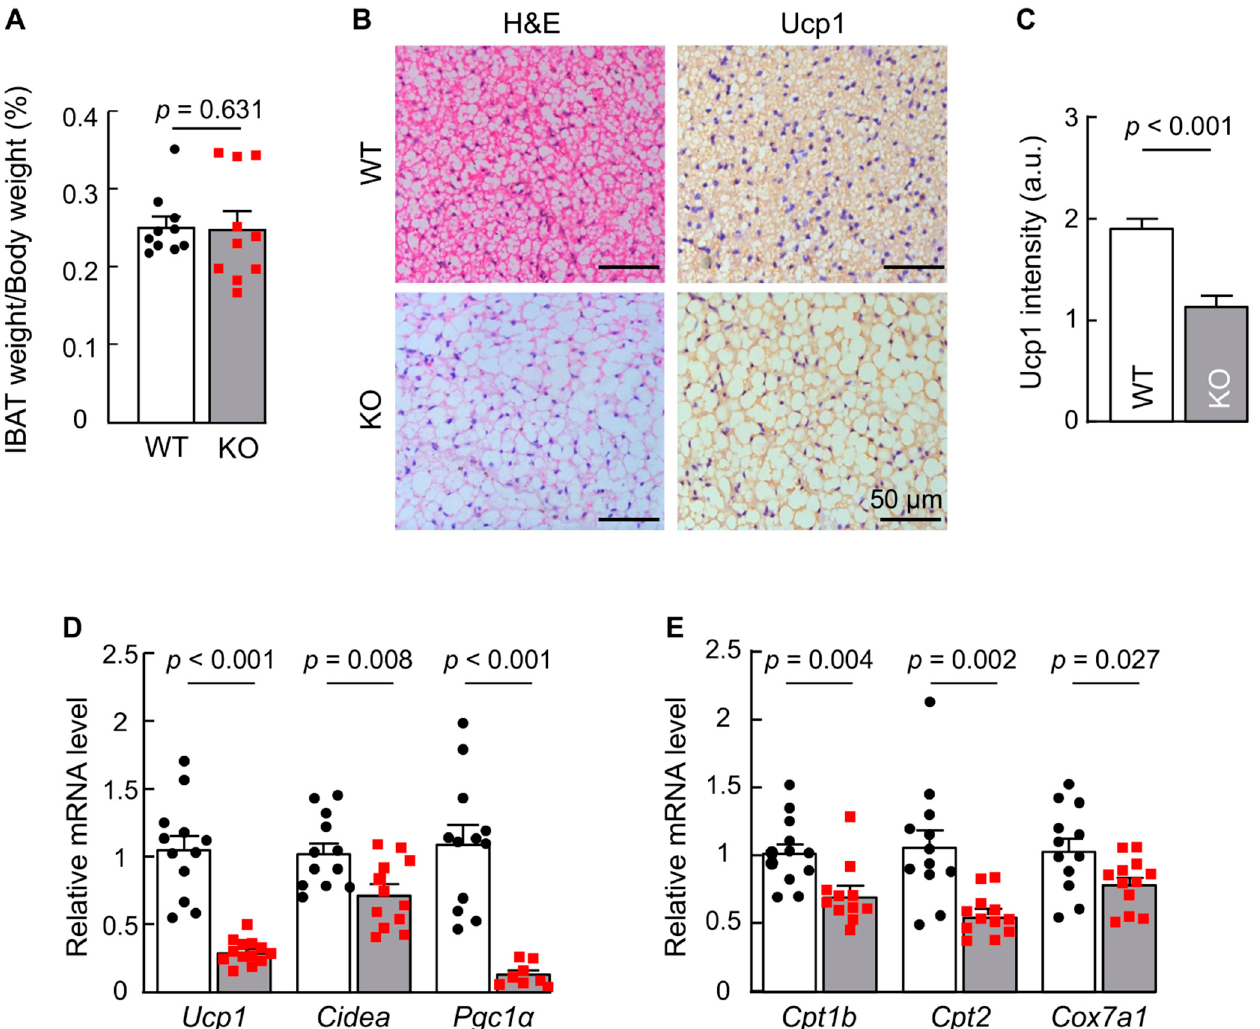
Figure 2. Analysis of iBAT from WT and corin KO mice. ( A ) Interscapular BAT (iBAT) weight vs. body weight ratio from WT and corin KO mice (males, 4 months old) ( n = 10). ( B ) H&E and Ucp1 staining of iBAT sections from 4-month-old male WT and corin KO mice. The data are representative of at least three experiments. Scale bars: 50 μ m. ( C ) Relative Ucp1 staining intensities in arbitrary units (a.u.) were analyzed with Image Pro software. At least 4 fields from each section and at least 4 sections per mouse ( n = 3) were examined. Each group includes data from at least 48 fields. Individual data for each field are not shown. ( D , E ) Levels of Ucp1 , Cidea , Pgc1 ( D ), Cpt1 , Cpt2, and Cox7a ( E ) mRNA expression in iBAT from 4-month-old male WT and corin KO mice were determined by qRT-PCR ( n = 8–13). Data of mean ± SEM are shown. p values were assessed by Student’s t test ( A , D , Cpt2 and Cox7a1 in E ) or Mann-Whitney test ( C and Cpt1b in E ).